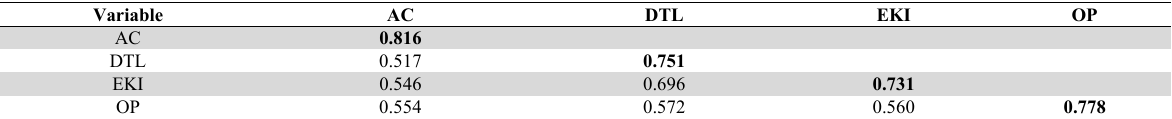
Fornell-Larcker Criterion Variable AC